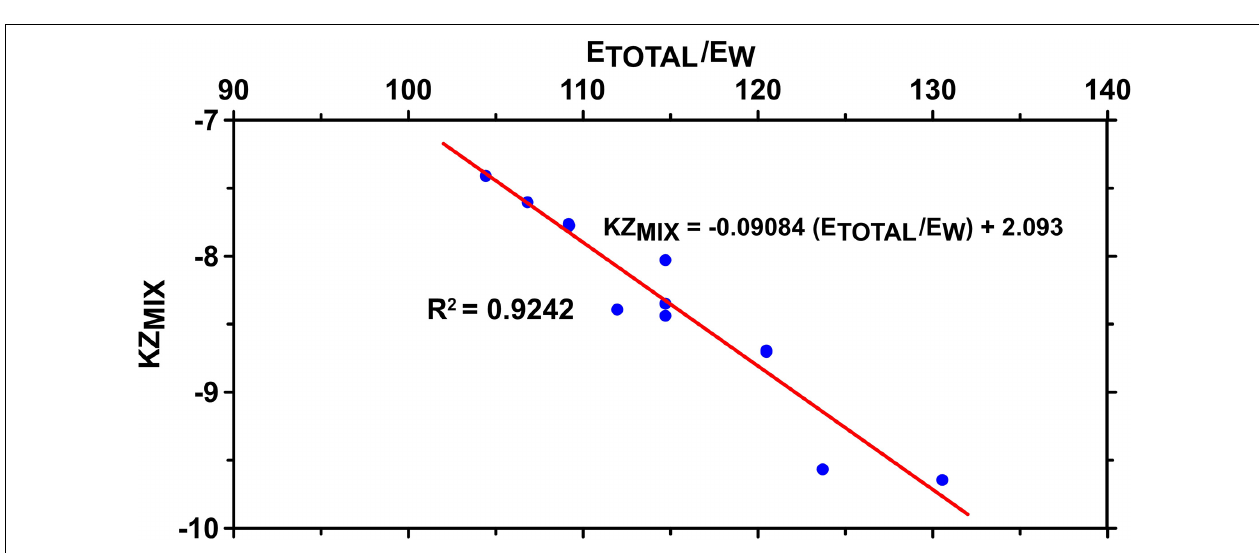
FIGURE 4 | Seasonal variation of the average isothermal, mixed, and barrier layer thickness in the Aracati Bank area.